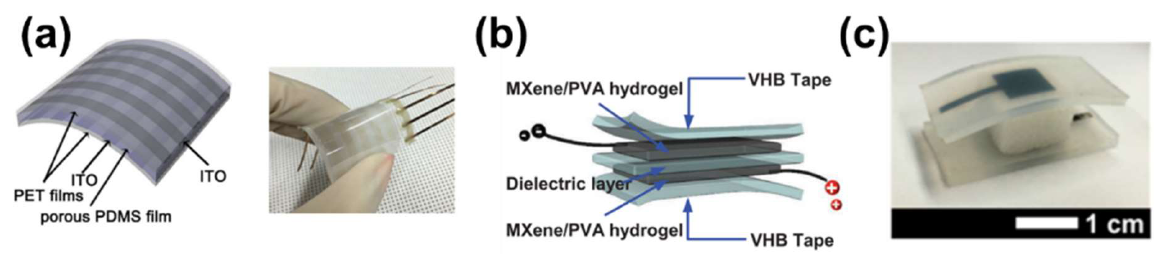
Figure 2. Schematics of sensor structure. ( a ) A flexible pressure sensor based on a porous PDMS film between two ITO-coated flexible PET substrates [51]. Copyright © 2021 Elsevier B.V. All rights reserved. ( b ) A MXene/PVA hydrogel capacitive sensor [45]. © 2021 WILEY-VCH Verlag GmbH & Co. KGaA, Weinheim. ( c ) A CNT/Ecoflex ® nanocomposite film electrode layer [52]. Copyright © 2021, American Chemical Society.